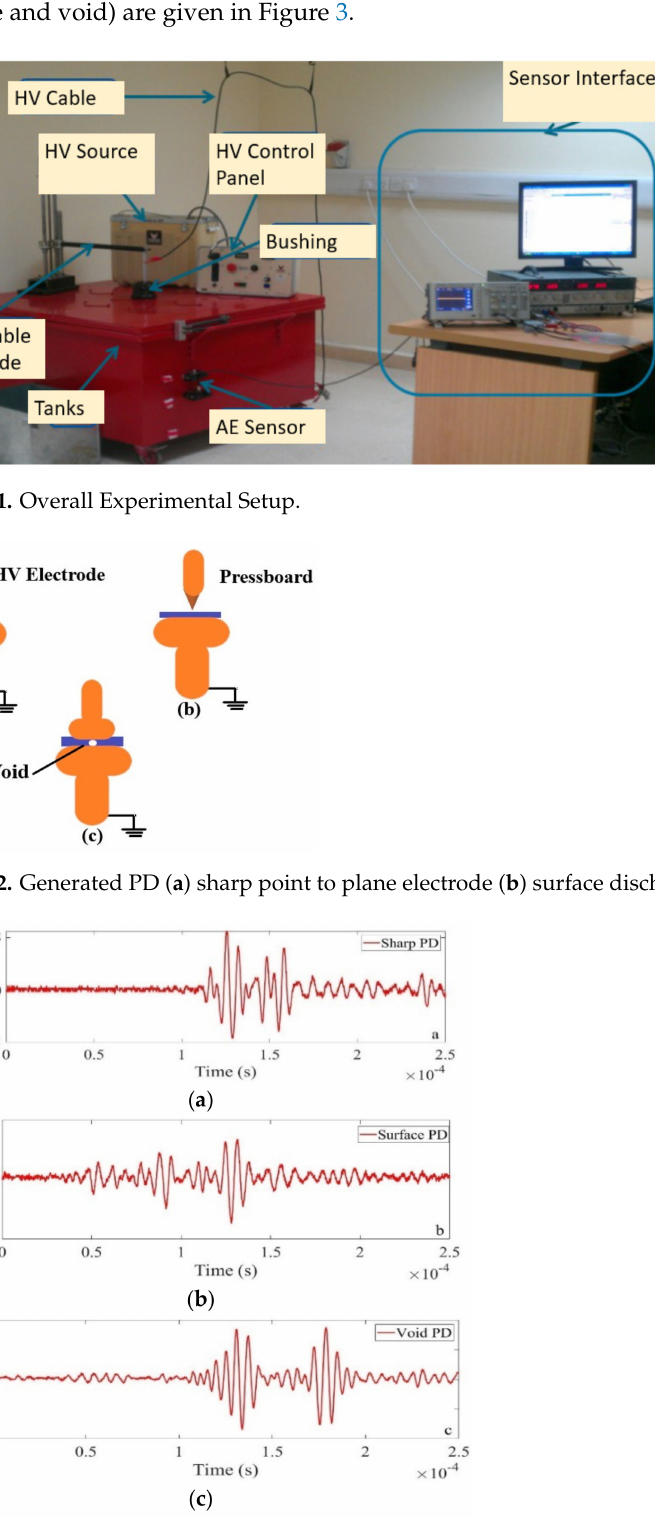
Figure 3. Laboratory measured PD signals. ( a ) Sharp PD, ( b ) Surface PD, ( c ) Void